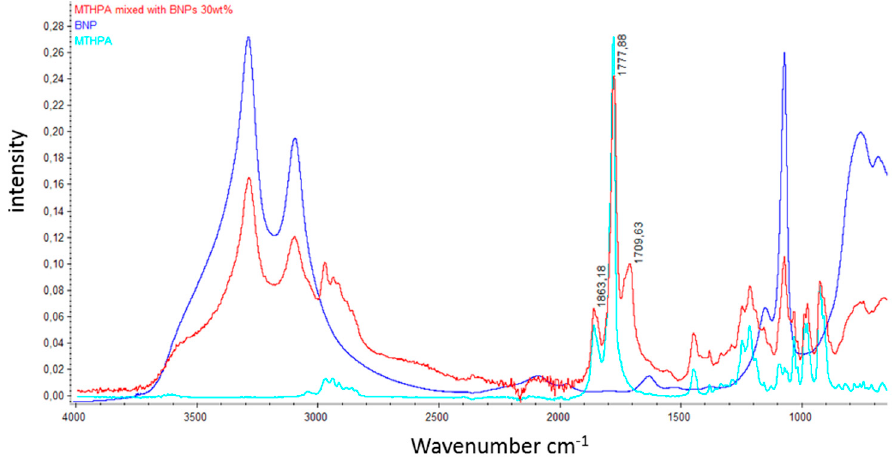
Figure A7. Room temperature ATR-IR spectra of BNPs, epoxy resin DGEBA and the masterbatch mixture of BNPs and DGEBA.